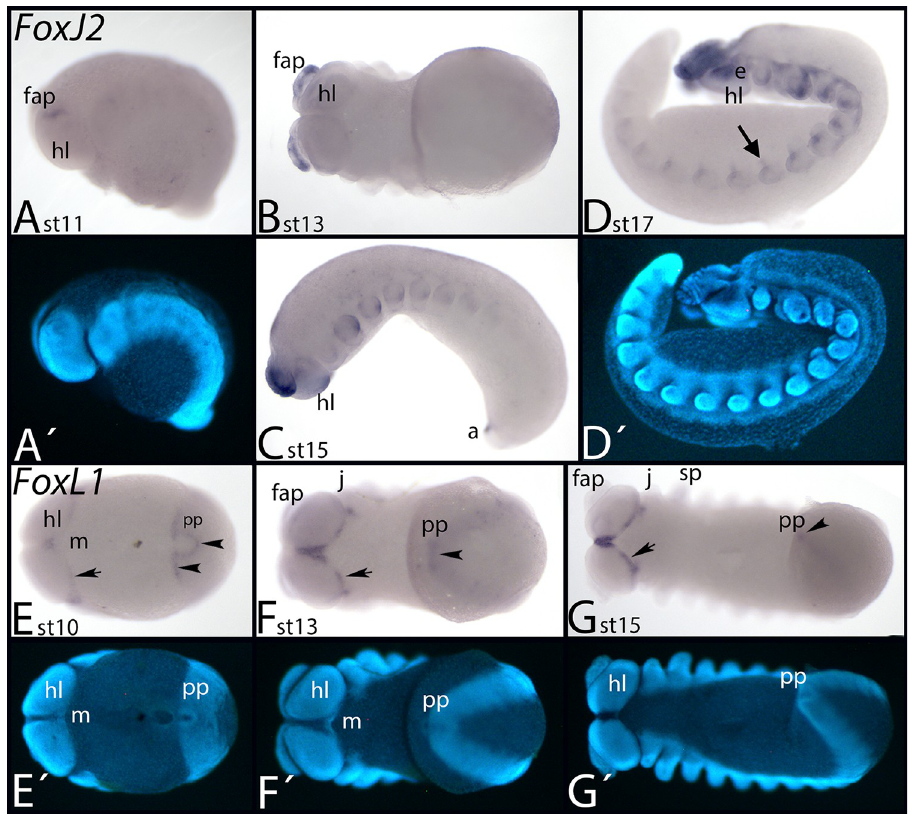
Fig 14. Expression of Euperipatoides FoxJ2 (A-D) and FoxL (E-G). In all panels, anterior is to the left. Panels A, C and D lateral view. Panels B, and E-G ventral view. A´, D´ and E´-G´ represent DAPI staining of the embryos shown A, D and E-G. Arrow in panel D marks expression ventral to the base of the walking legs. Arrows and arrowheads in panels E-G point to expression at the posterior rim of the head lobes and the posterior pit respectively. Abbreviations in Table